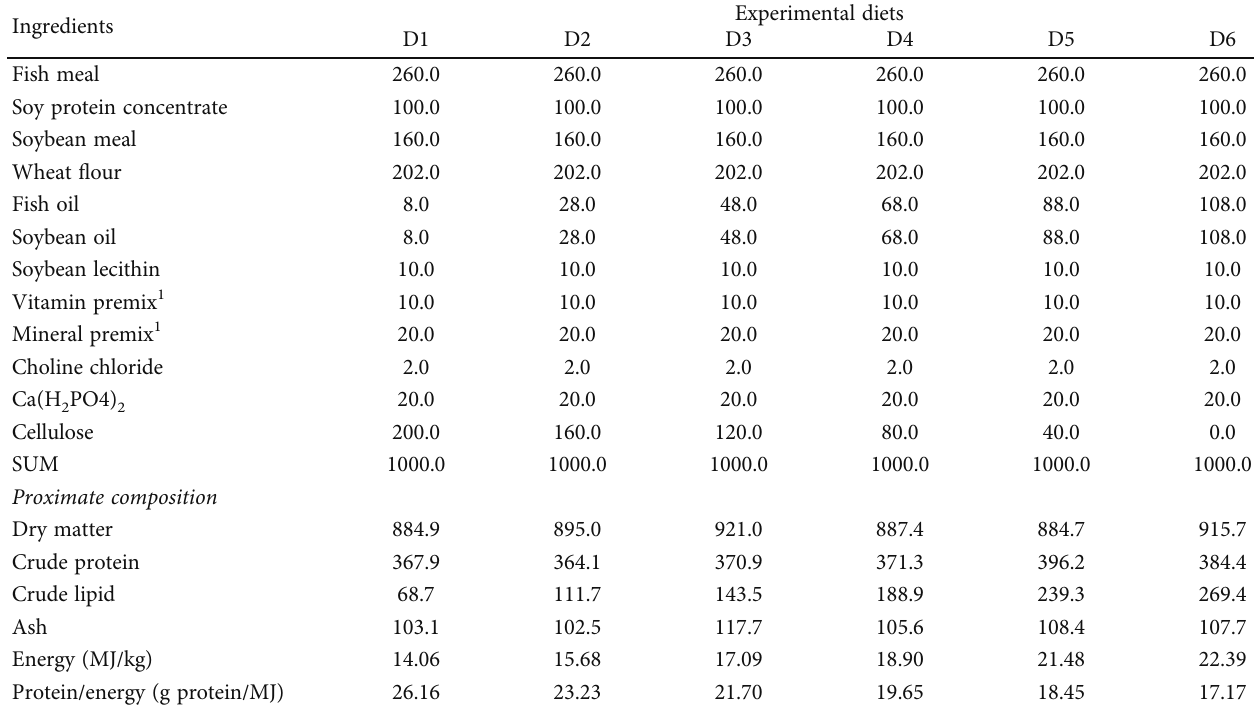
Table 1: Ingredients and proximate composition of the experimental diets (g/kg, dry matter) [20].